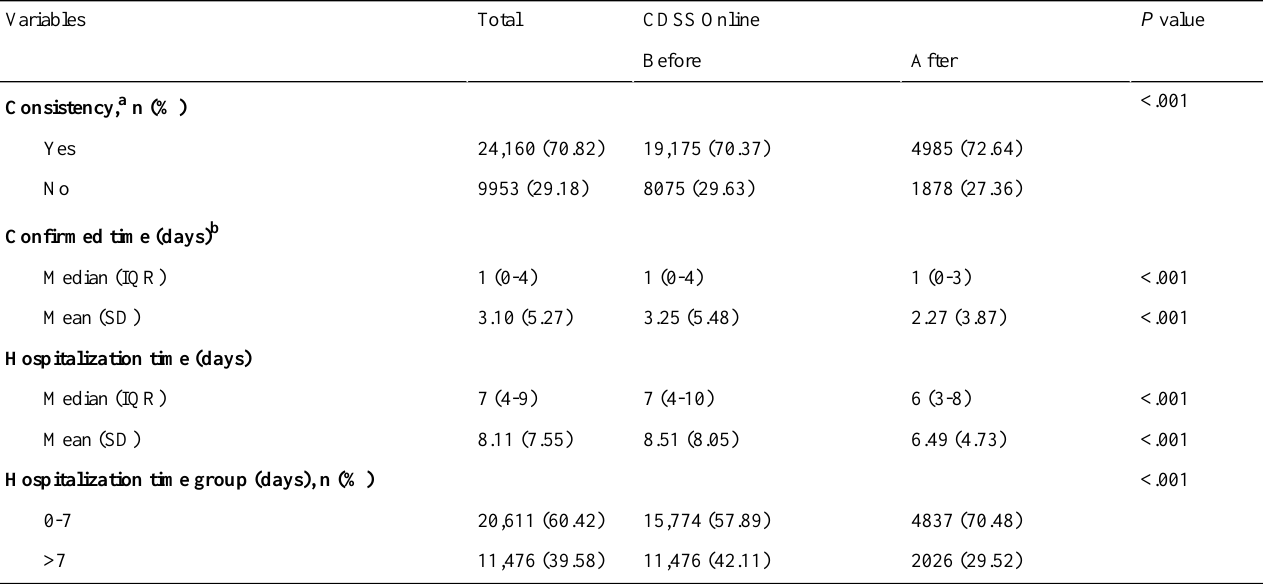
Table 3. Comparison of the effects of CDSS (clinical decision support systems) before and after CDSS implementation.